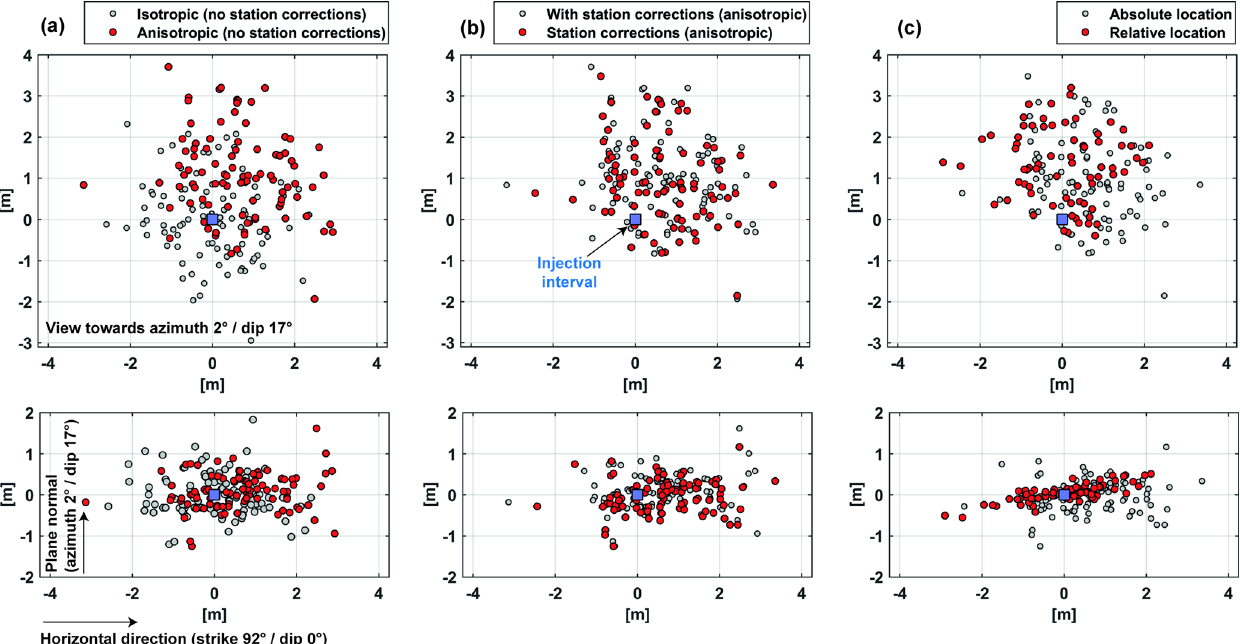
Figure 7. Impact of anisotropy and station corrections and relative location on source locations. The upper panel is always a projection onto the plane of the largest extent of the seismicity clouds. The lower panels are projections perpendicular to the seismicity cloud. (a) Isotropic vs. anisotropic velocity models with station corrections not included. (b) With and without station corrections for the anisotropic velocity model. (c) Absolute vs. relative locations for the anisotropic velocity